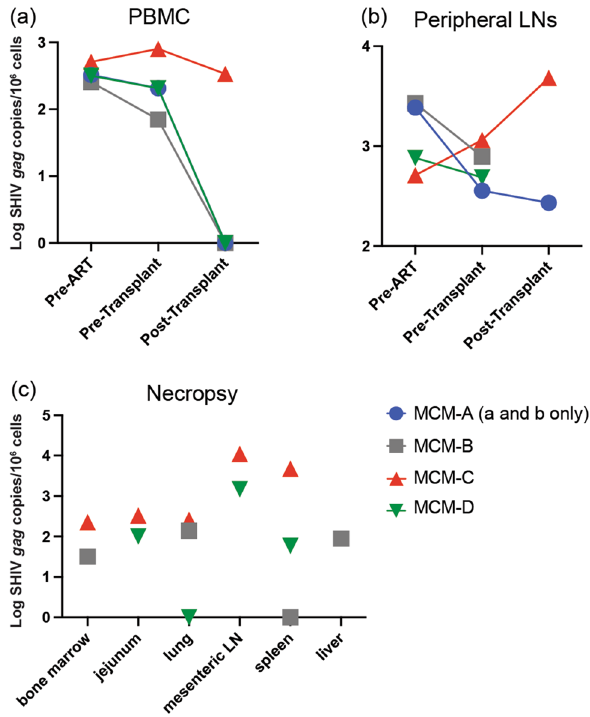
Figure 4. SHIV DNA in allo-HSC transplanted MCMs. We measured copies of vDNA in ( a ) PBMCs and ( b ) peripheral lymph nodes before ART initiation, after ART but before allo-HSCTs, and post-transplant. ( c ) SHIV DNA levels in the tissues of MCMs B, C, and D at necropsy. Total SHIV DNA was measured by digital droplet PCR using SIV gag -specific primers and normalized to 10 6 cells by measuring macaque RNaseP p30,